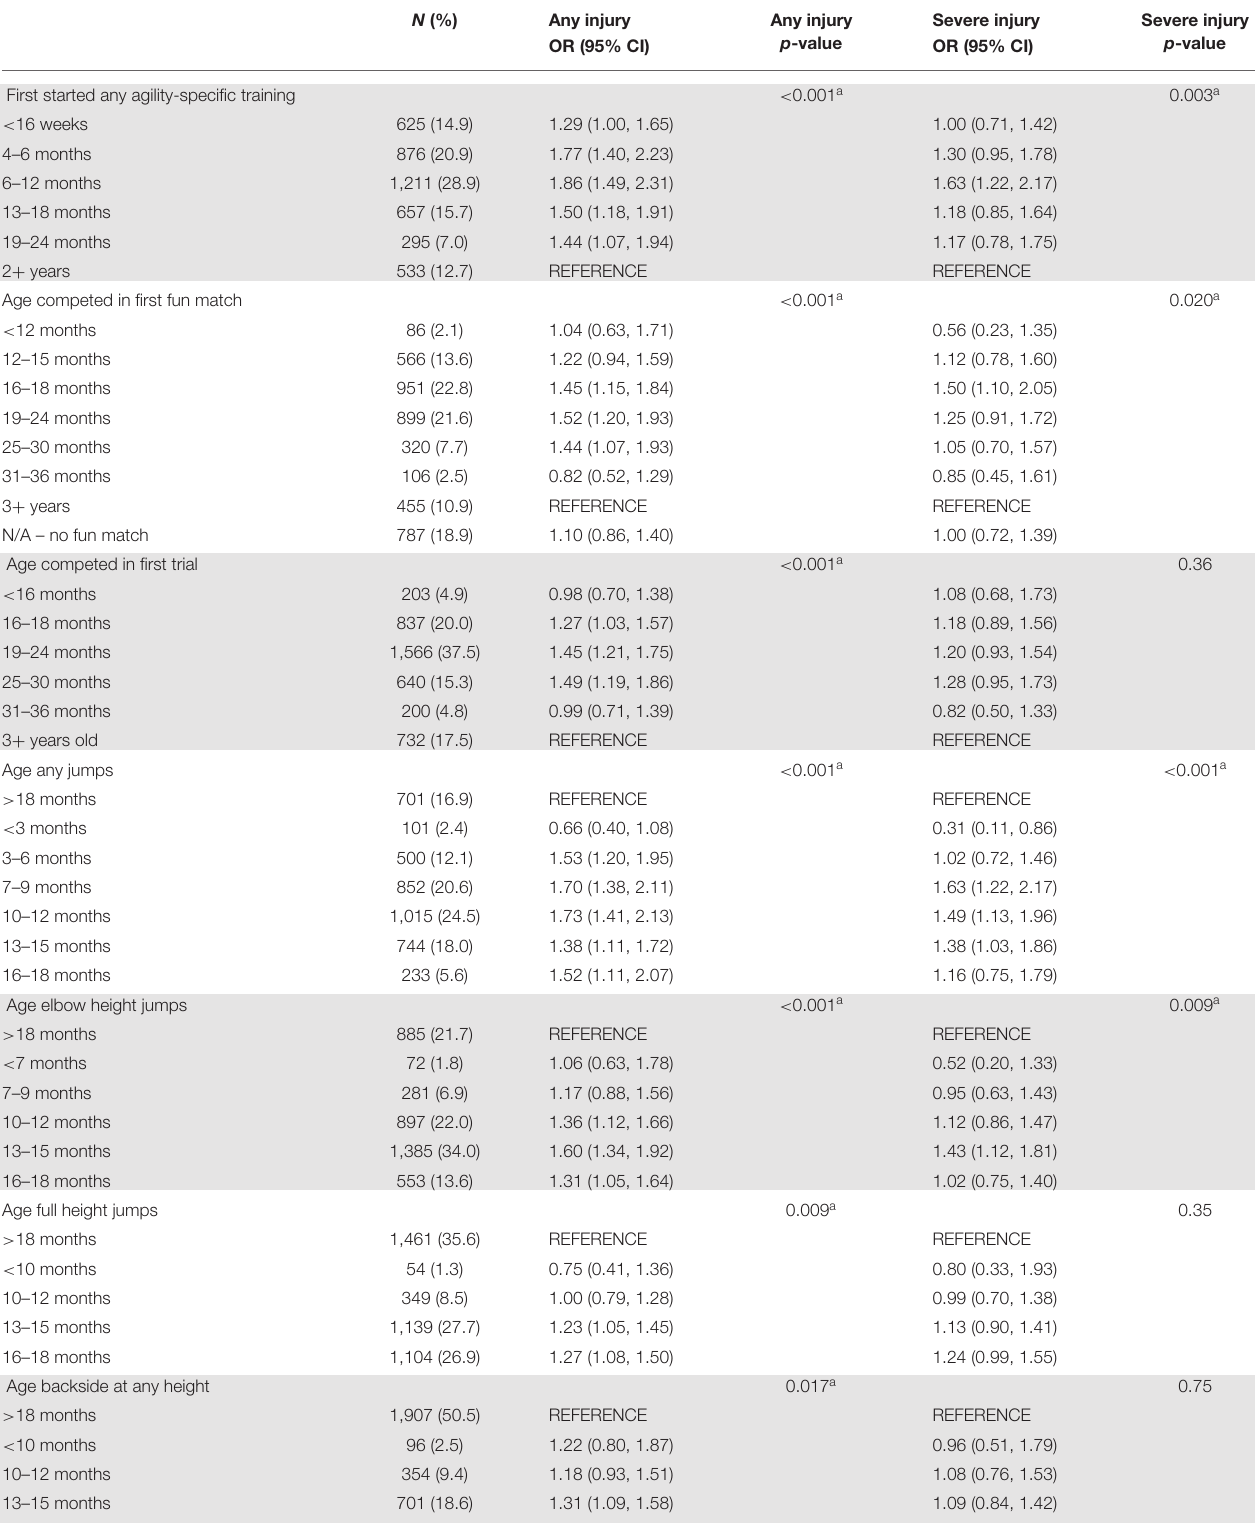
TABLE 4 | Age adjusted associations between training risk factors and injury